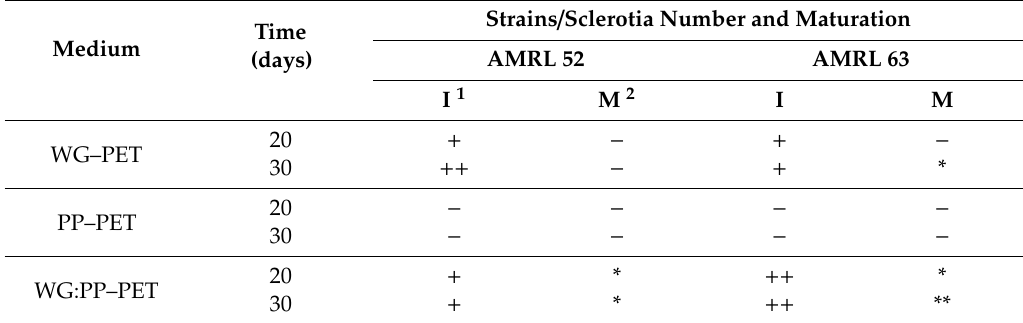
Table 5. Sclerotia formation and maturation of yellow AMRL 52 and black AMRL 63 morel strains grown on wheat grains (WG), potato peels (PP), and a mixture of them (WG–PP, 1:1). Strains / Sclerotia Number and Maturation Time Medium AMRL 52 AMRL 63 (days) I 1 M 2 I